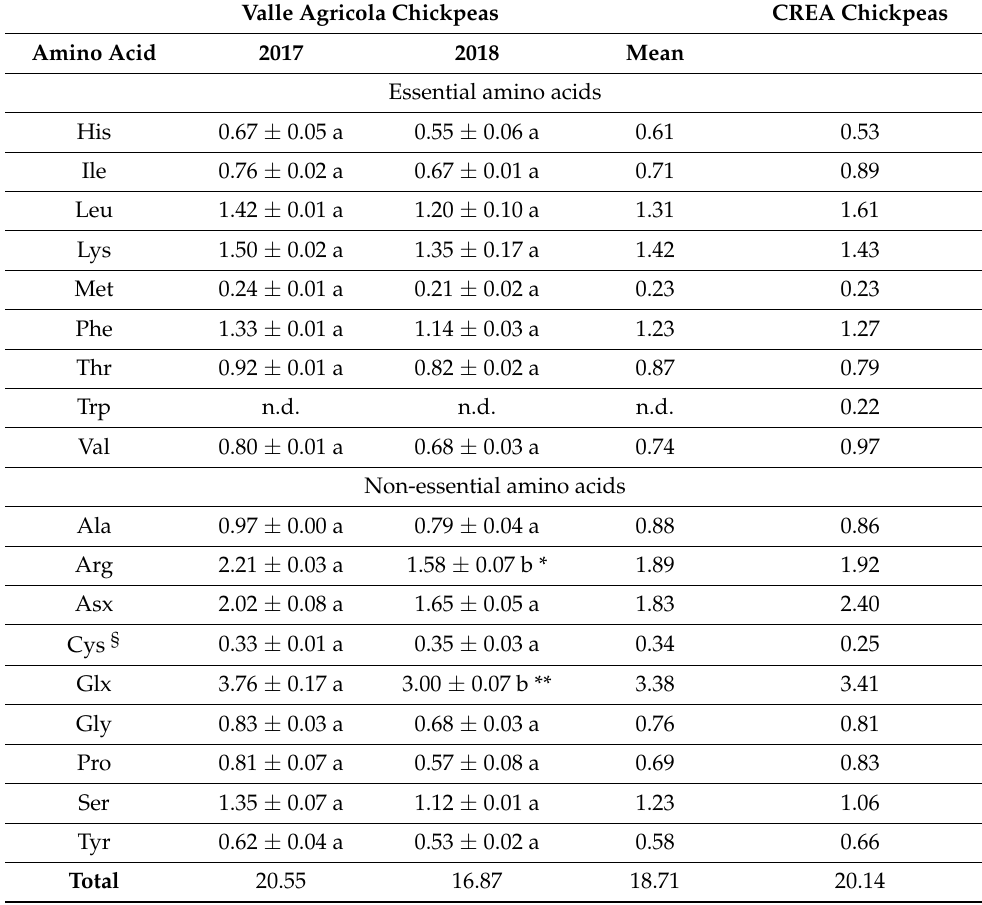
For protein amino acids, a three-letter code has been used. Values followed by different letters (a, b) within a row are significantly ( p < 0.05) different by Bonferroni post-test. *, ** indicate significant at p < 0.05 and p < 0.01, respectively. § , Cys amount was evaluated after performic acid oxidation. n.d. not